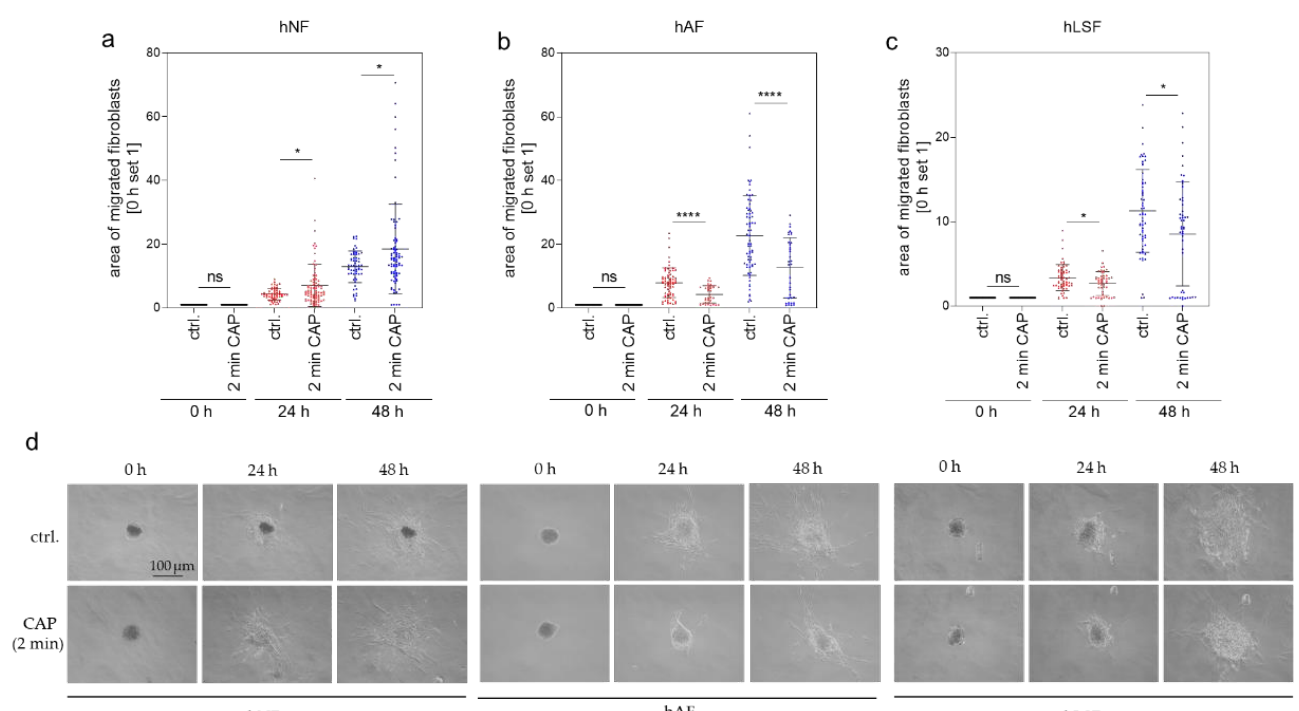
Figure 2. Cell migration out of 3-dimensional (3-D) spheroids. hNF ( a ), hAF ( b ) and hLSF ( c ) spheroids were analyzed for their migratory ability. CAP-treated and untreated spheroids were seeded into a collagen matrix (0 h). The migratory ability of the cells out of the spheroid was analyzed after 24 and 48 h. The spheroid area at time 0 h was set to 1 and was analyzed in comparison to the area determined after 24 and 48 h. The area of the migrated fibroblasts as exemplarily shown in ( d ) was calculated from three independent experiments with n indicating the number of total analyzed spheroids (hNF: n = 58–82; hAF: n = 35–70; hLSF: n = 50–61). Statistical analysis: The Student’s unpaired t test and the nonparametric Mann–Whitney test were used to show differences between the medians of two groups. Significant results compared to the corresponding untreated control are indicated * p ≤ 0.05, **** p < 0.0001, ns = not significant. Scale bar = 100 μm.